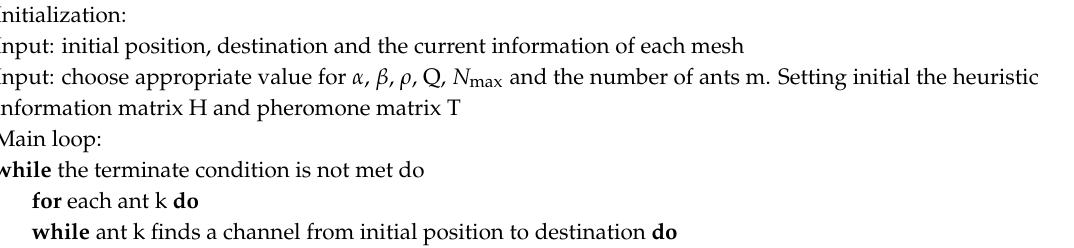
Algorithm 1. Upper level